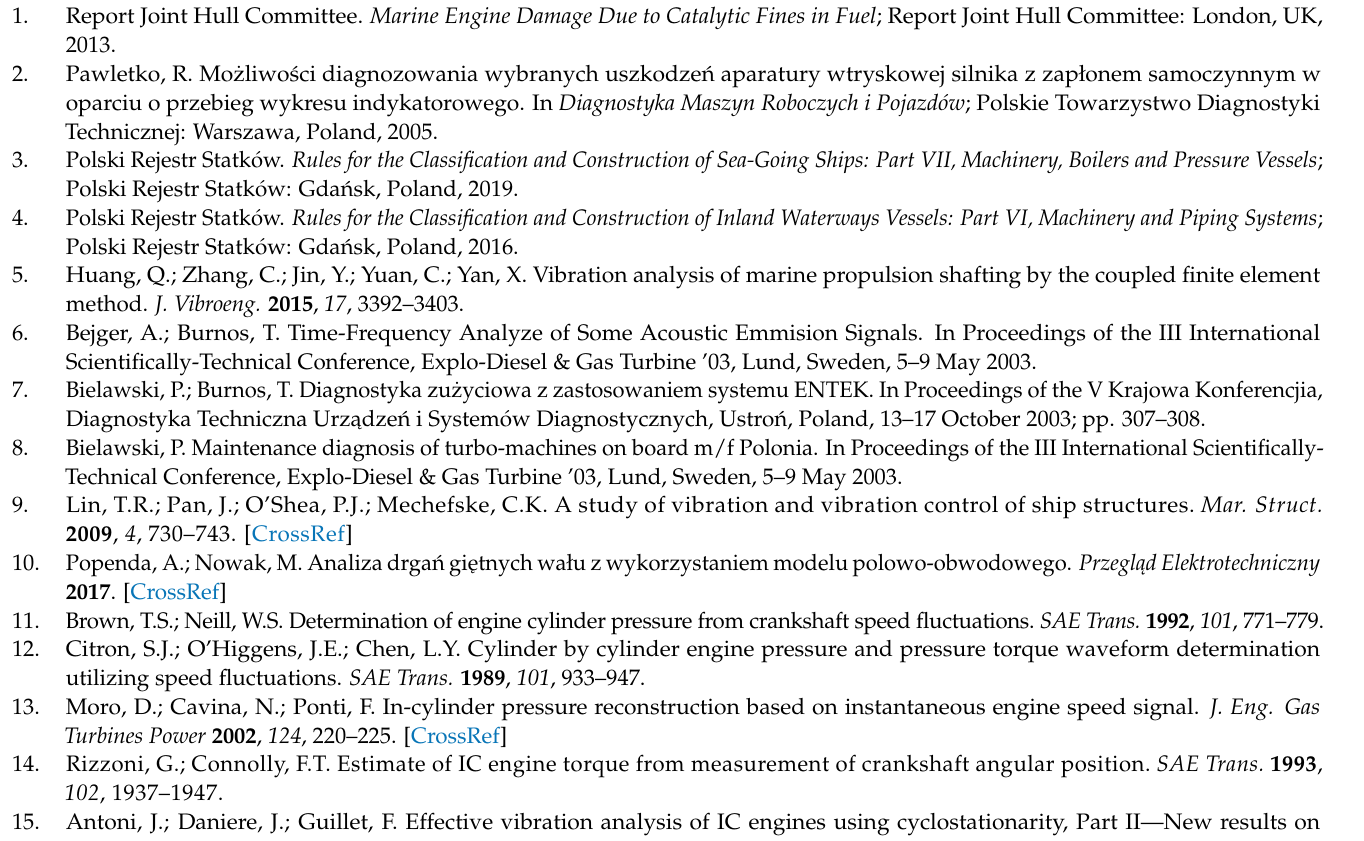
(e) The values of harmonic component orders obtained are clearly visible in the spectra (Figure 8); (f) Torsional vibration spectra of the DEU with a defective injector nozzle were different from those obtained for a defect-free engine (Figure 13); (g) The distribution of differences in the values of the first sixteen harmonic components depend on the cylinder in which the defective injector nozzle was installed. The observations made lead to a conclusion that it is possible to diagnose coking of a ship diesel engine injection nozzle by relying on spectral analysis of the shaft’s torsional vibrations which are measured by optical